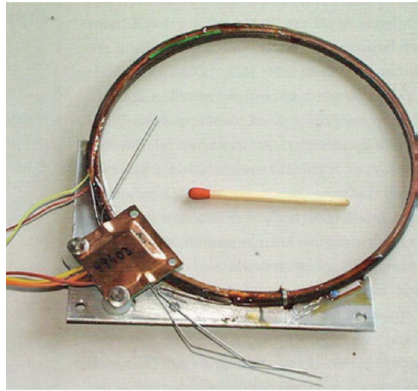
Figure 8. Fused silica capillary column installed on chirality module of the COSAC instrument on board Rosetta’s lander Philae [173].